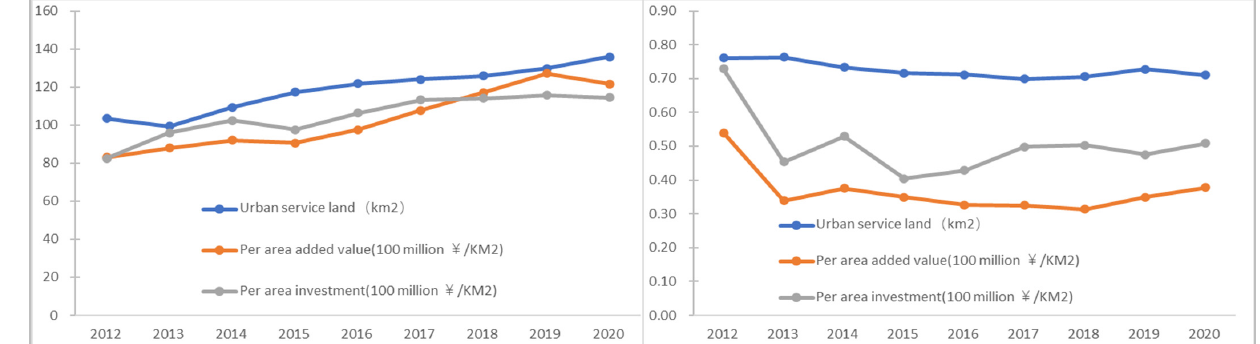
Figure 7. Analysis of average and coefficient of variation from 2012 to 2020.